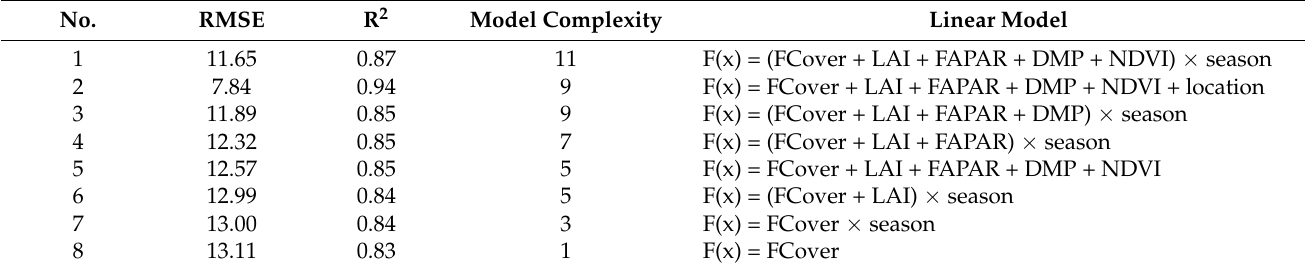
Table 7. Summary of each of the model